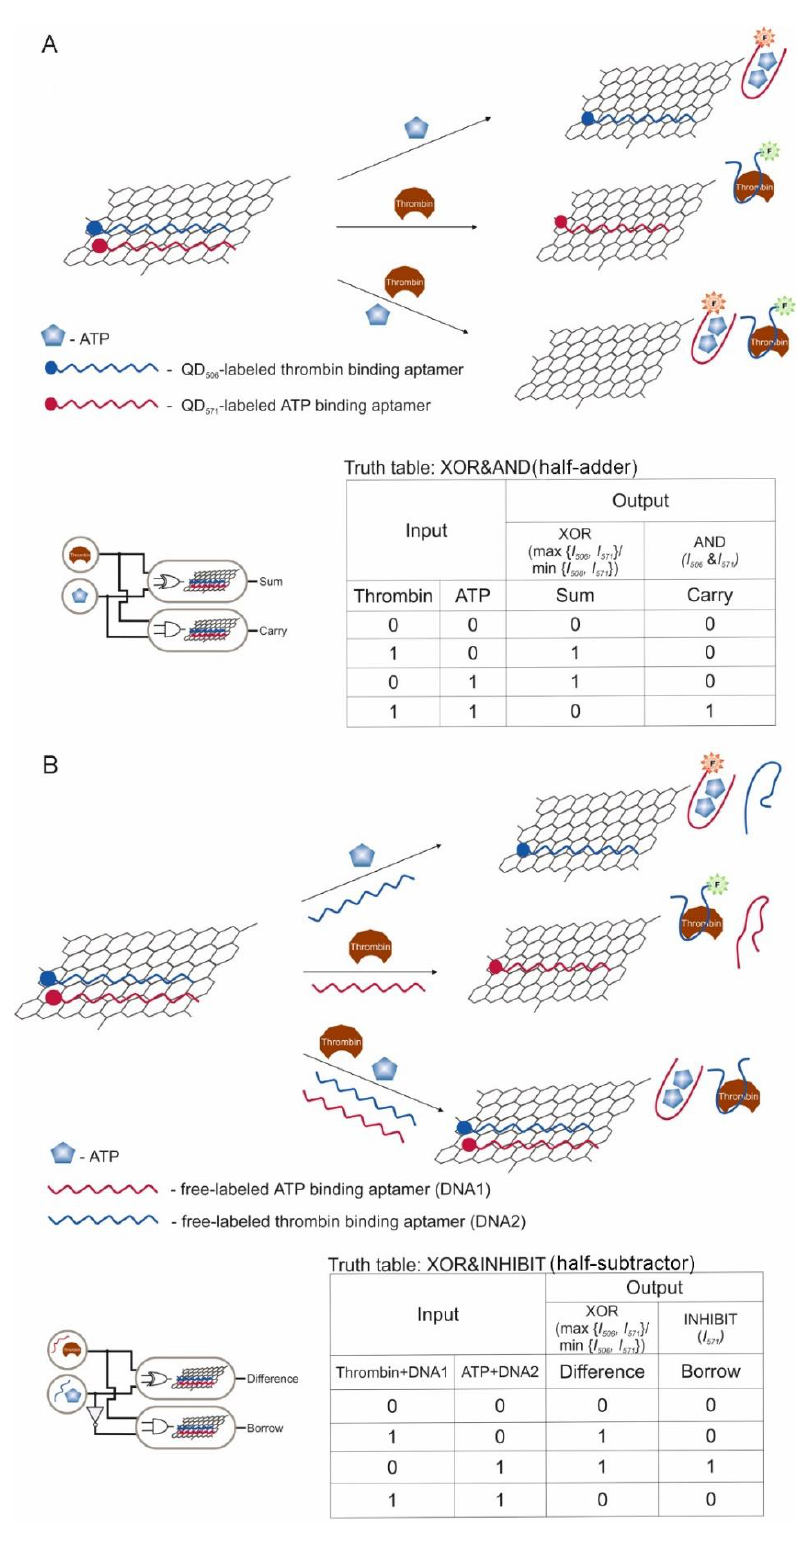
Figure 11. Half-adder ( A ) and half-subtractor ( B ) functions. ATP = adenosine triphosphate. Adapted from Reference [64] by permission of The Royal Society of Chemistry.